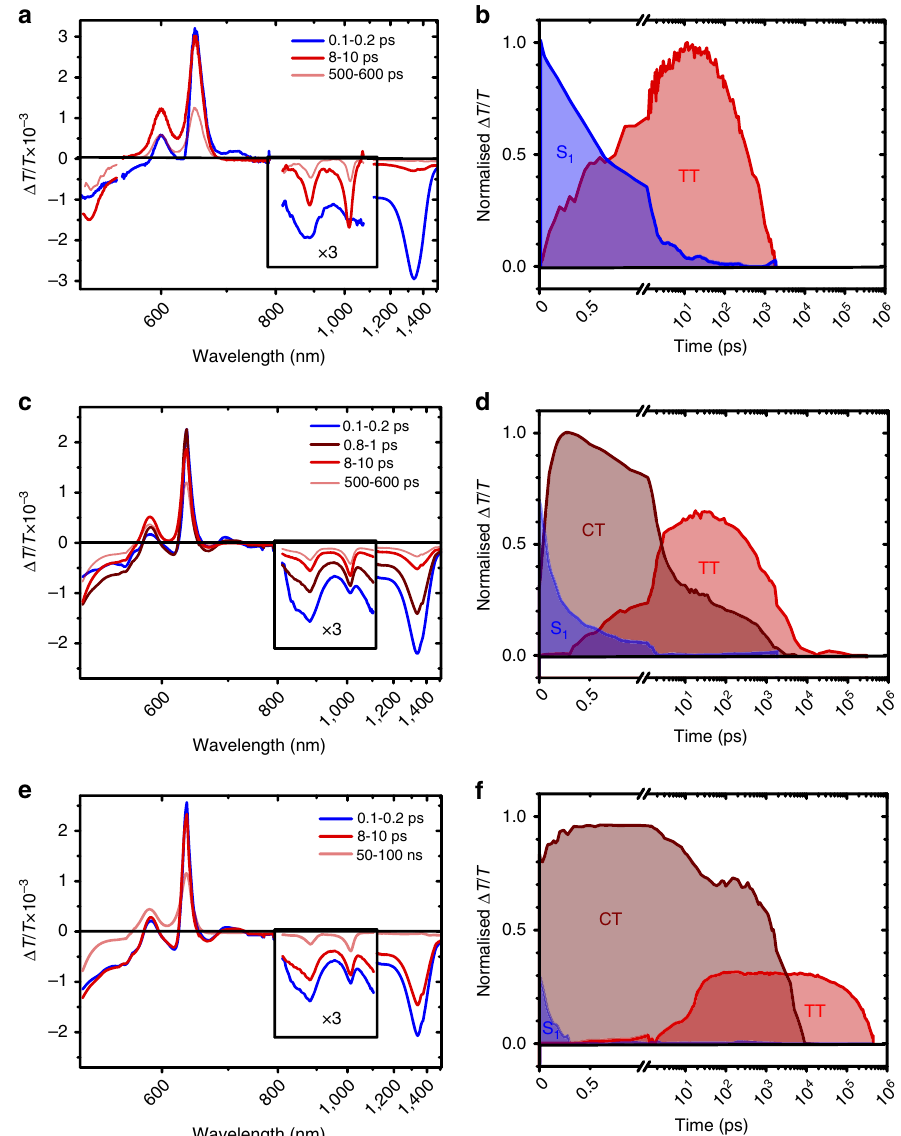
Figure 8 | SF in DP-TIPS in polymer matrix. TA spectra of DP-TIPS embedded in polymer matrices with different glass transition temperatures: ( a ) PS ( c ) PVAc and ( e ) PEO. The same features of S 1 and TTare evident in the matrices as in solution. The NIR spectral range has been scaled by a factor of 3 for clarity. The characteristic dual PIA of CT at 620 and 650nm can only be detected in PVAc and PEO matrices. The population kinetics for S 1 , CT and TT obtained from spectral decomposition are presented in ( b , d , f ). The CTpopulation is significantly stabilized in both PVAc and PEO, and the triplet lifetime is also greatly enhanced in the relatively soft PEO